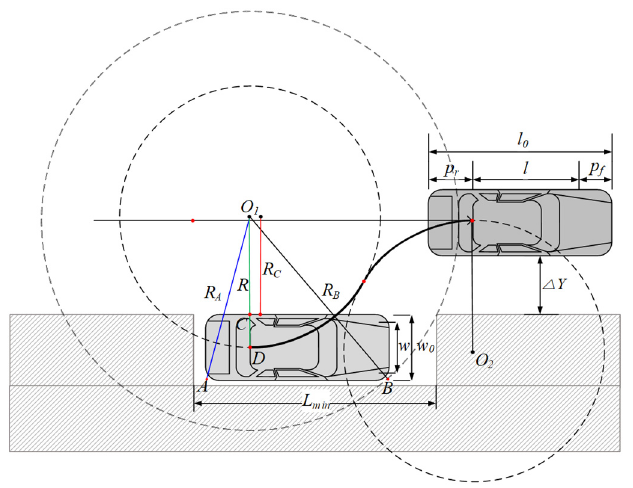
Figure 5. Three-characters ( 𝑆 (cid:2878) 𝑅 (cid:2879) 𝐿 (cid:2879) ) parallel